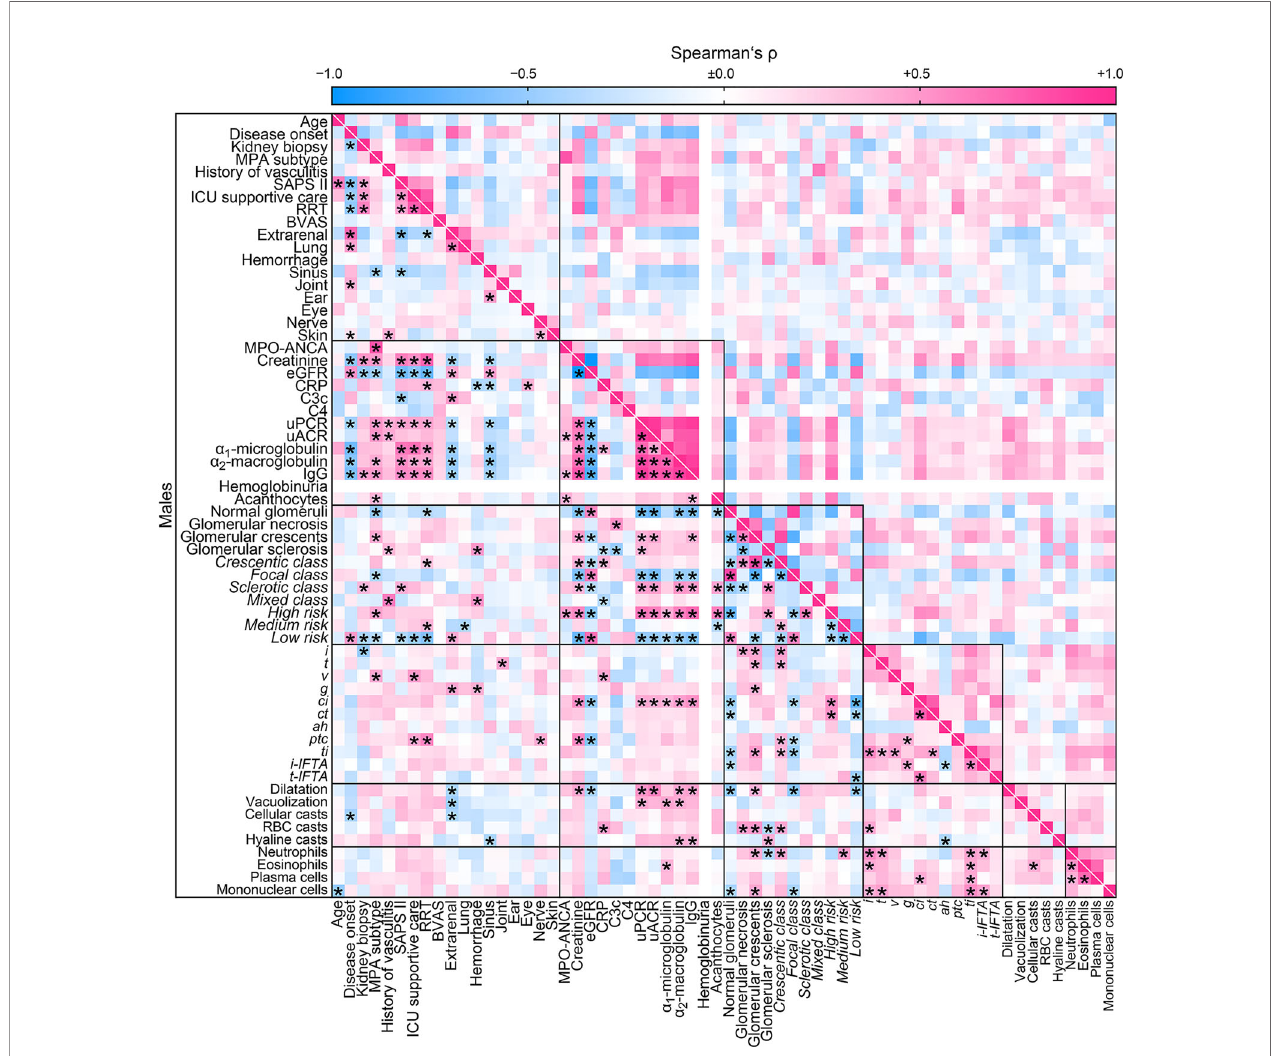
FIGURE 5 | Male-speci fi c cluster analysis for the association between clinical, laboratory parameters, and histopathological fi ndings in ANCA GN. Associations of clinical, laboratory parameters, and histopathological clusters in ANCA GN speci fi cally in males are shown by heatmap re fl ecting mean values of Spearman ’ s r , asterisks indicate p < 0.05 . Clusters are depicted by black boxes, the empty line for hemoglobinuria within the heatmap re fl ects no data analysis because the respective parameter was present in all cases. ah , arteriolar hyalinosis; ANCA, anti-neutrophil cytoplasmic antibodies; ATI, acute tubular injury; BVAS, Birmingham Vasculitis Activity Score; C3c, complement factor 3 conversion product; C4, complement factor 4; ci , interstitial fi brosis; CRP, C-reactive protein; ct , tubular atrophy; eGFR, estimated glomerular fi ltration rate; g , glomerulitis; GN, glomerulonephritis; i , interstitial in fl ammation; IgG, immunoglobulin G; i-IFTA , in fl ammation in IFTA;